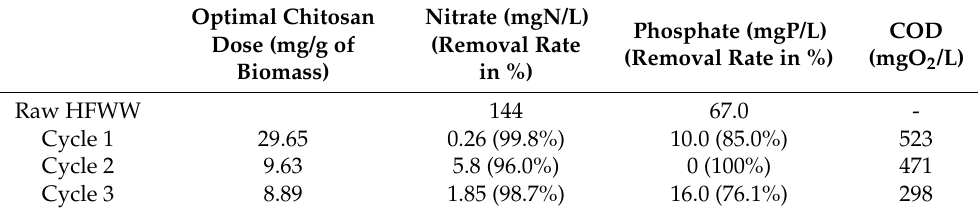
Table 4. Concentrations in nitrate (mgN/L), phosphate (mgP/L), Chemical Oxygen Demand (COD) (mgO 2 /L) in the supernatant resulting from chitosan coagulation of HFWWC culture. Nitrate and phosphate removal rates in % in